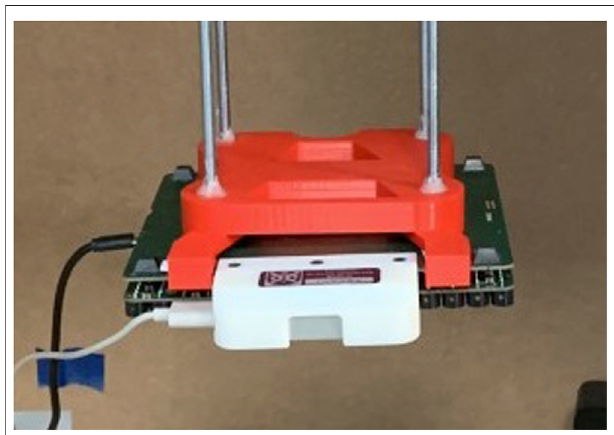
FIGURE 1 | Con fi guration of haptics module.